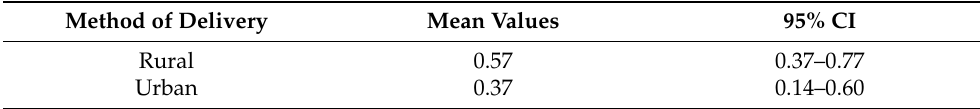
Table 8. The patients’ PUUS values regarding the origin of the parturients.